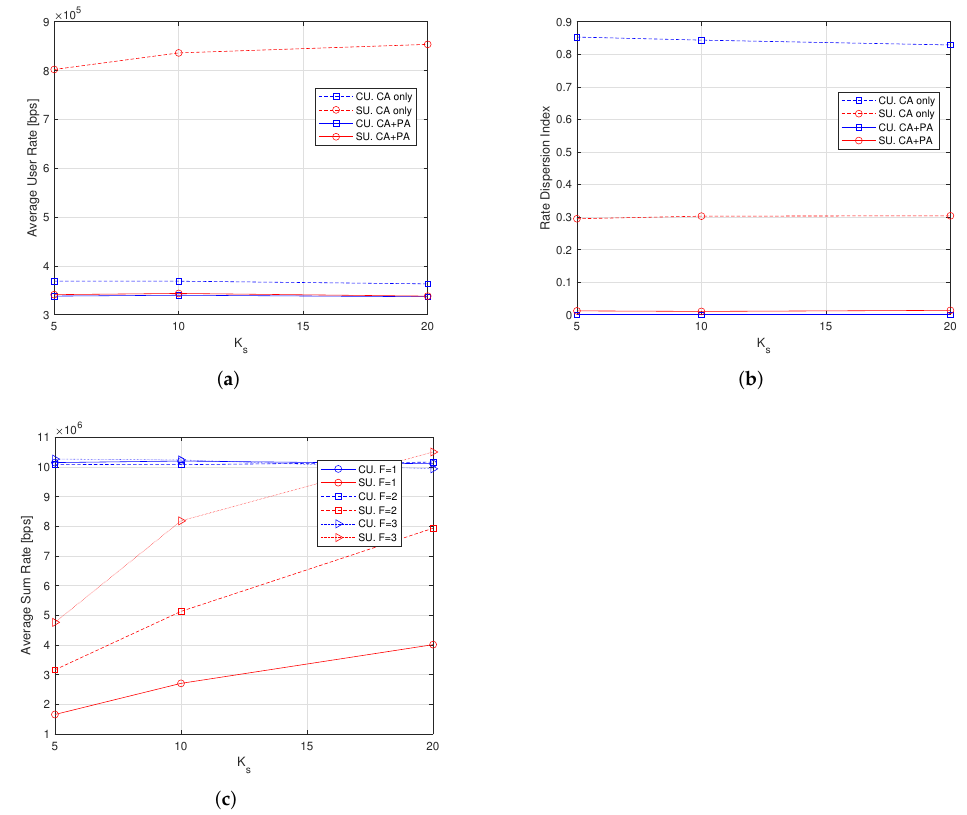
Figure 8. Average Sum-Rate with K c = 30 users, 100 iterations. ( a ) Varying K s , α = 1, CE-aware; ( b ) Varying K s , α = 1, CE-unaware; ( c ) Varying α , K s = 10, CE-aware; ( d ) Varying α , K s = 10, CE-unaware.